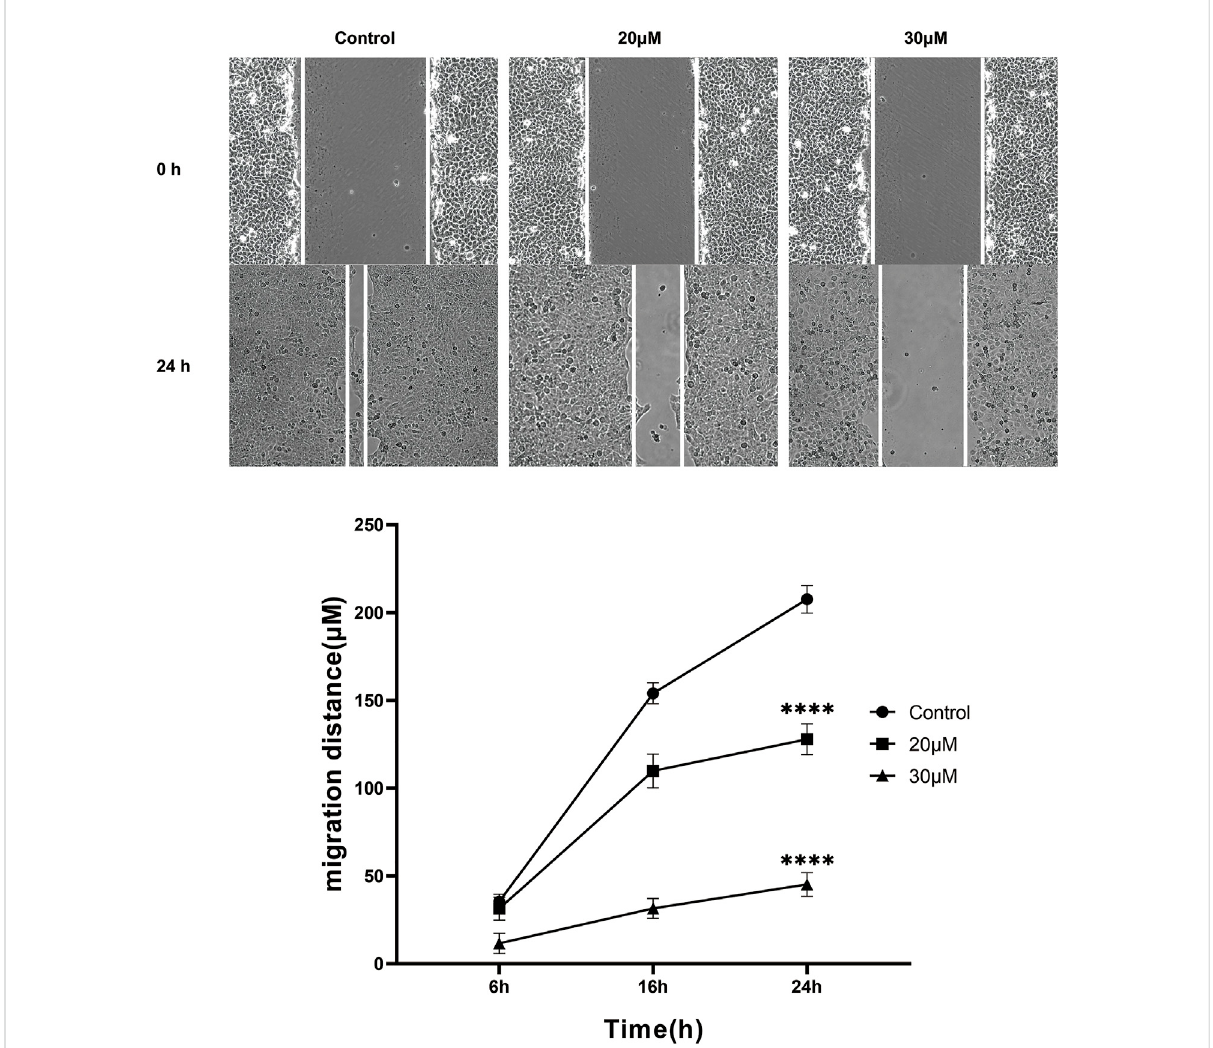
FIGURE 6 Cell migration evaluation by scratch wound assay. The SK-MEL-1 cells were treated with curcumin in concentrations of 0, 20, and 30 μ M. Cell migrationwassigni fi cantlysuppressed incurcumin-treatedgroupsincomparisontothatofthecontrolgroup.**p < 0.01and***p < 0.001,two-way